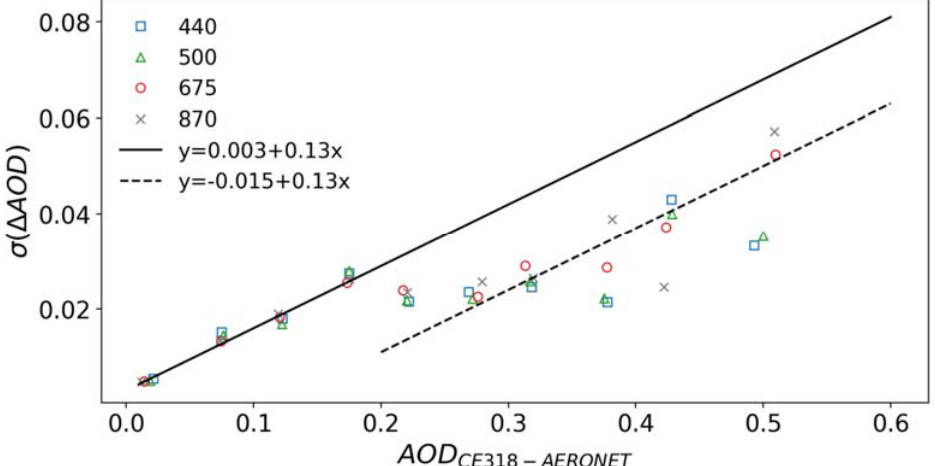
Figure 8. Standard deviation of the AOD di ff erences between CE318-AERONET and ZEN-R52 for di ff erent AOD intervals of 0.05 between zero and 0.6. Data at 440, 500, 675, and 870 nm, are represented by blue squares, green triangles, red circles, and grey crosses, respectively. The black solid line represents the fitting equation for the standard deviation of the AOD di ff erences for AOD values between zero and 0.2, while the broken black line depicts the fitting equation for the standard deviation of the AOD di ff erences for higher AOD values (0.25 to